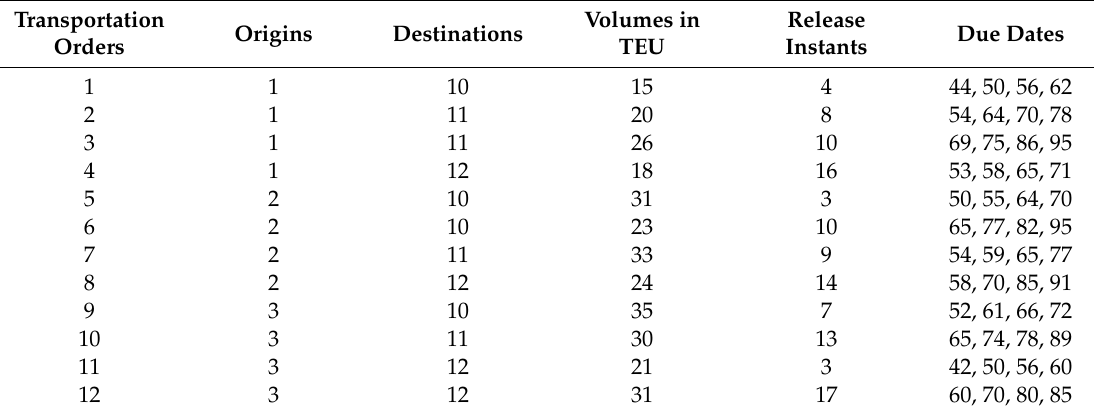
Table A4. Information on the transportation orders of the numerical